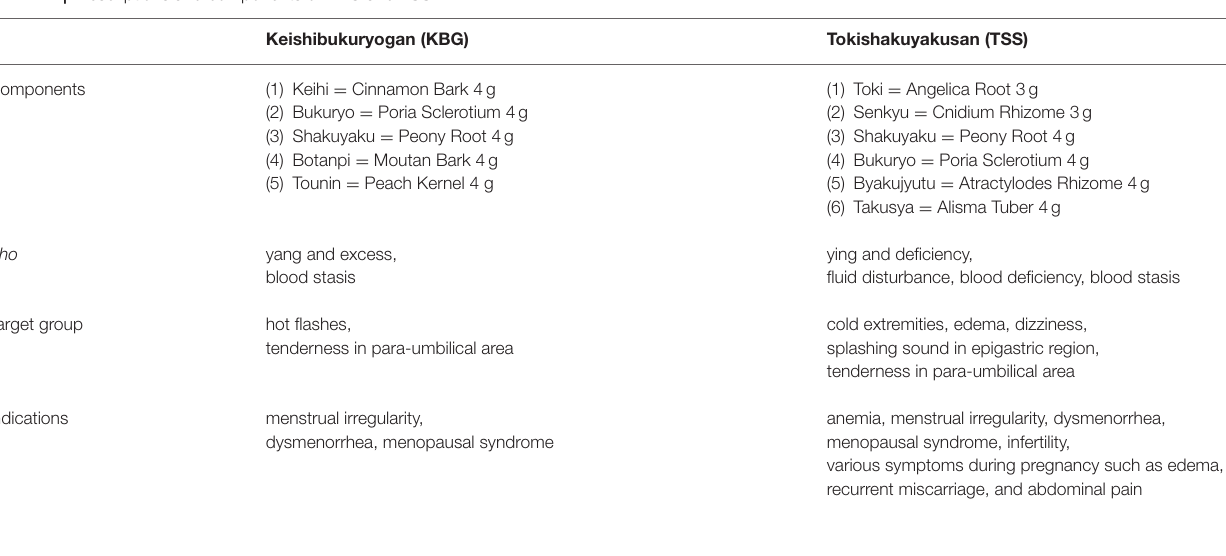
TABLE 1 | Prescriptions and components of KBG and